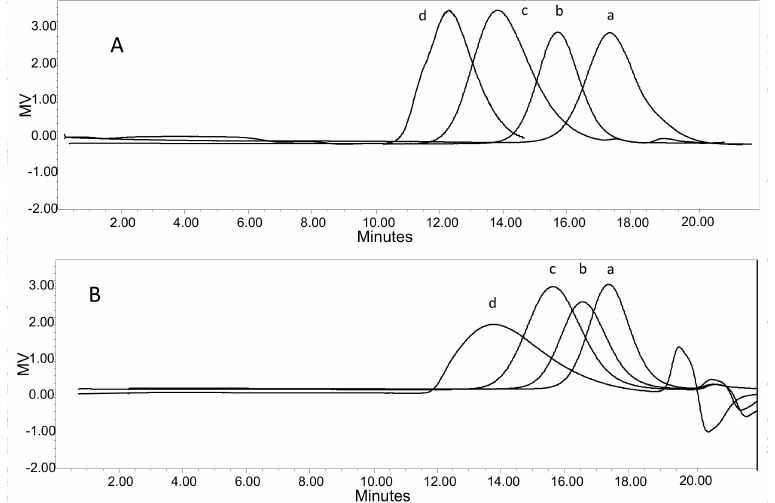
Figure 5. SEC elution profiles of ( A ) dextran 5 (a), carboxylated dextran derivative 6 (b), TSPO ligand conjugates 7 (c) and 10 (d); ( B ) dextran 5 (a), carboxylated dextran derivative 9 (b), TSPO ligand conjugates 8 (c) and 11